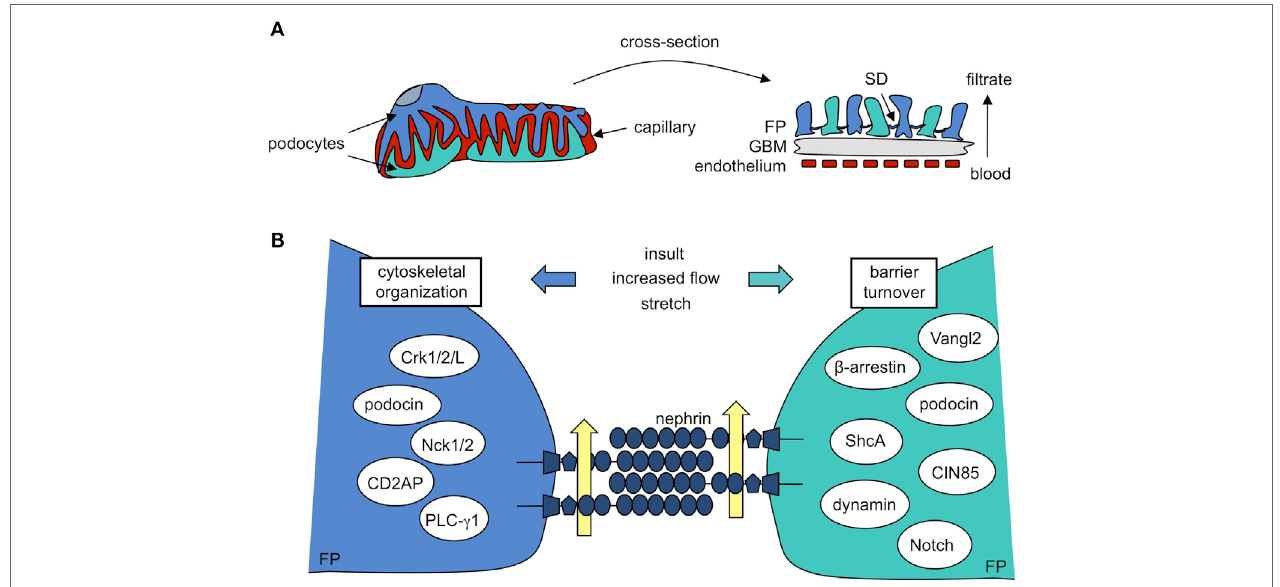
FiGURe 1 | Podocyte protein nephrin is a central component in formation and maintenance of the slit diaphragm (SD). (A) Kidney podocytes wrap finger-like projections around the capillaries of the glomerulus, and these culminate in a network of interacting foot processes (FP). FPs contribute to the glomerular filtration barrier, which is also made up of fenestrated endothelium and the intermediating glomerular basement membrane (GBM). The SD, a specialized podocyte–podocyte junction found between interdigitating FPs, largely determines the size-selectivity of the barrier. (B) A closer look reveals the SD is a molecular sieve made up of nephrin molecules. The repetitive nature and precise patterning of extracellular nephrin–nephrin regions form pores that allow for discerning filtration of the blood (yellow arrows). Nephrin’s cytoplasmic region recruits a variety of signaling molecules that regulate cytoskeletal organization and FP shape as well as barrier turnover, each of which contributes to SD maintenance